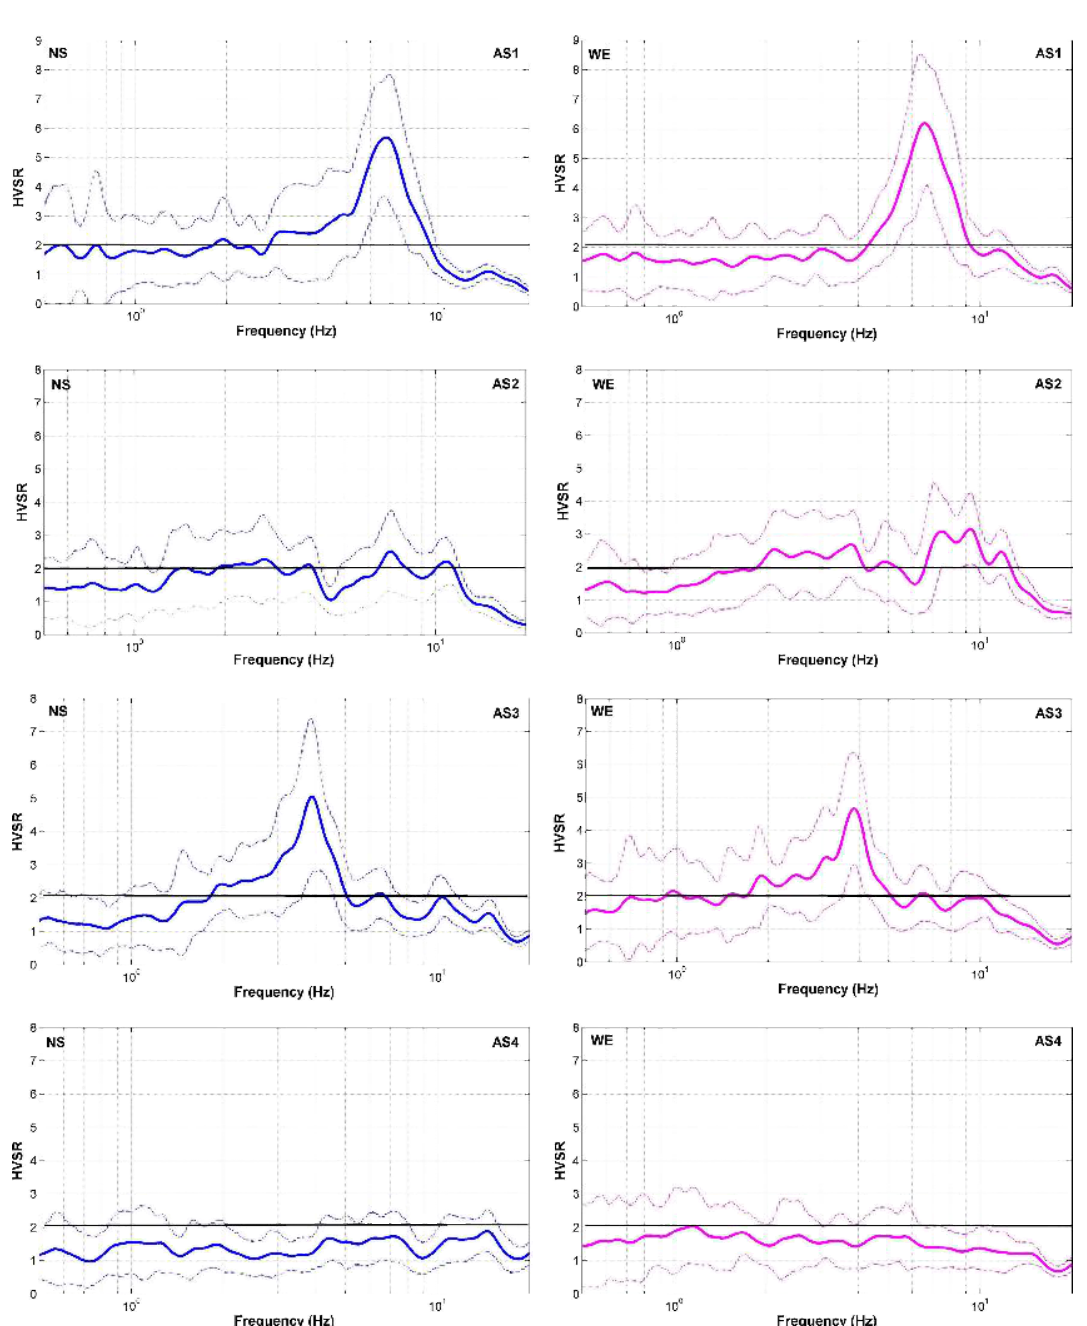
Figure 11: HVSR functions estimated in three sites of Pescara del Tronto (AS1, AS2, AS3) and in one of Vezzano